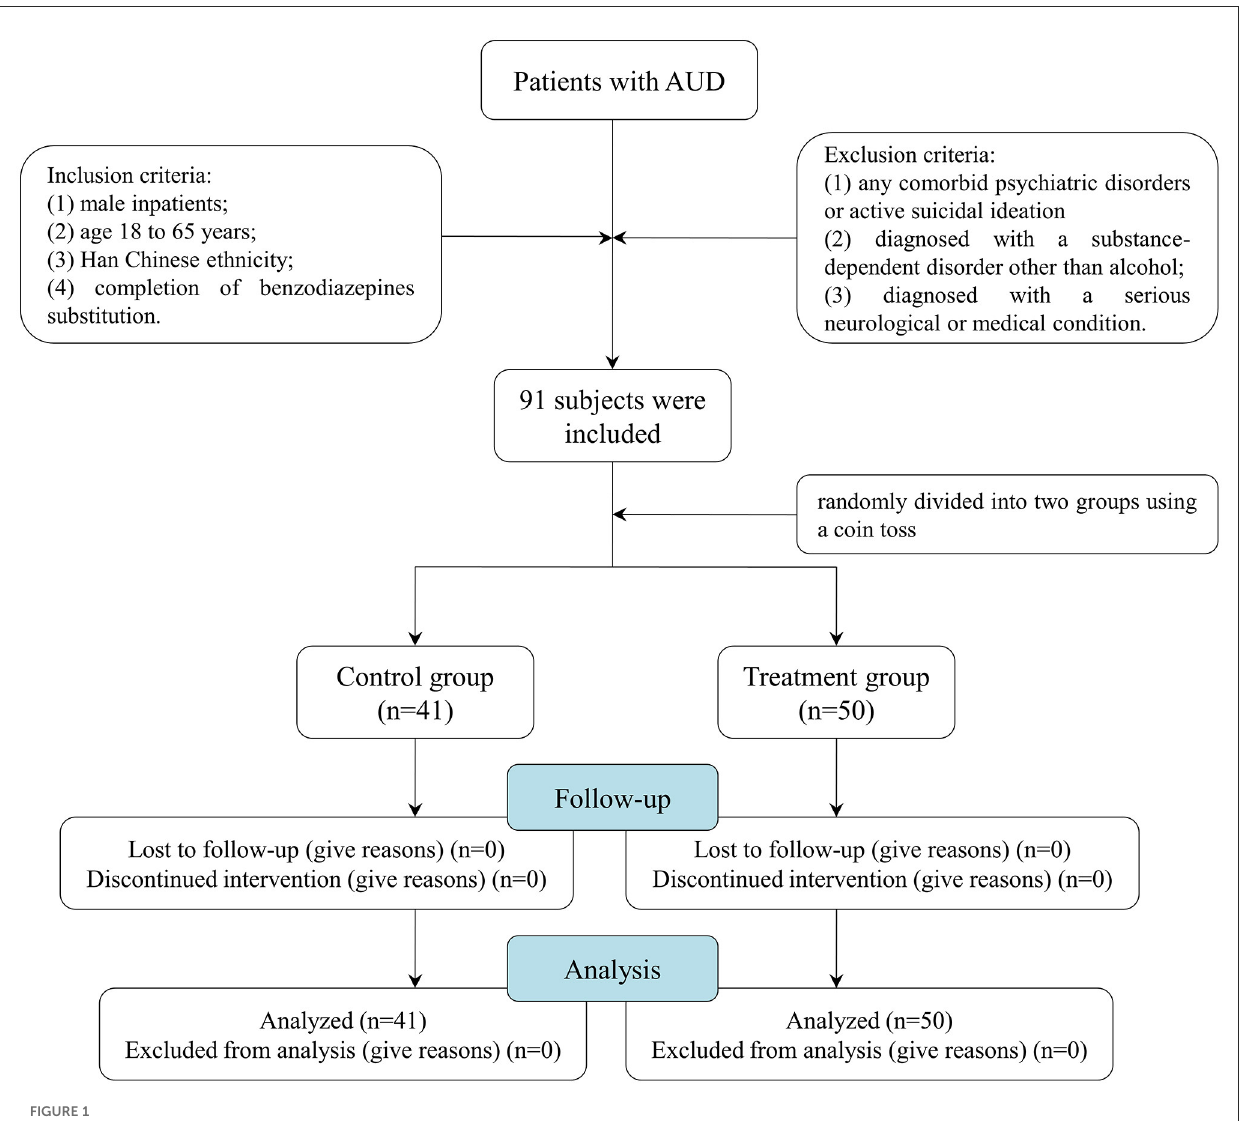
FIGURE1 Flowchart showing the enrollment process for